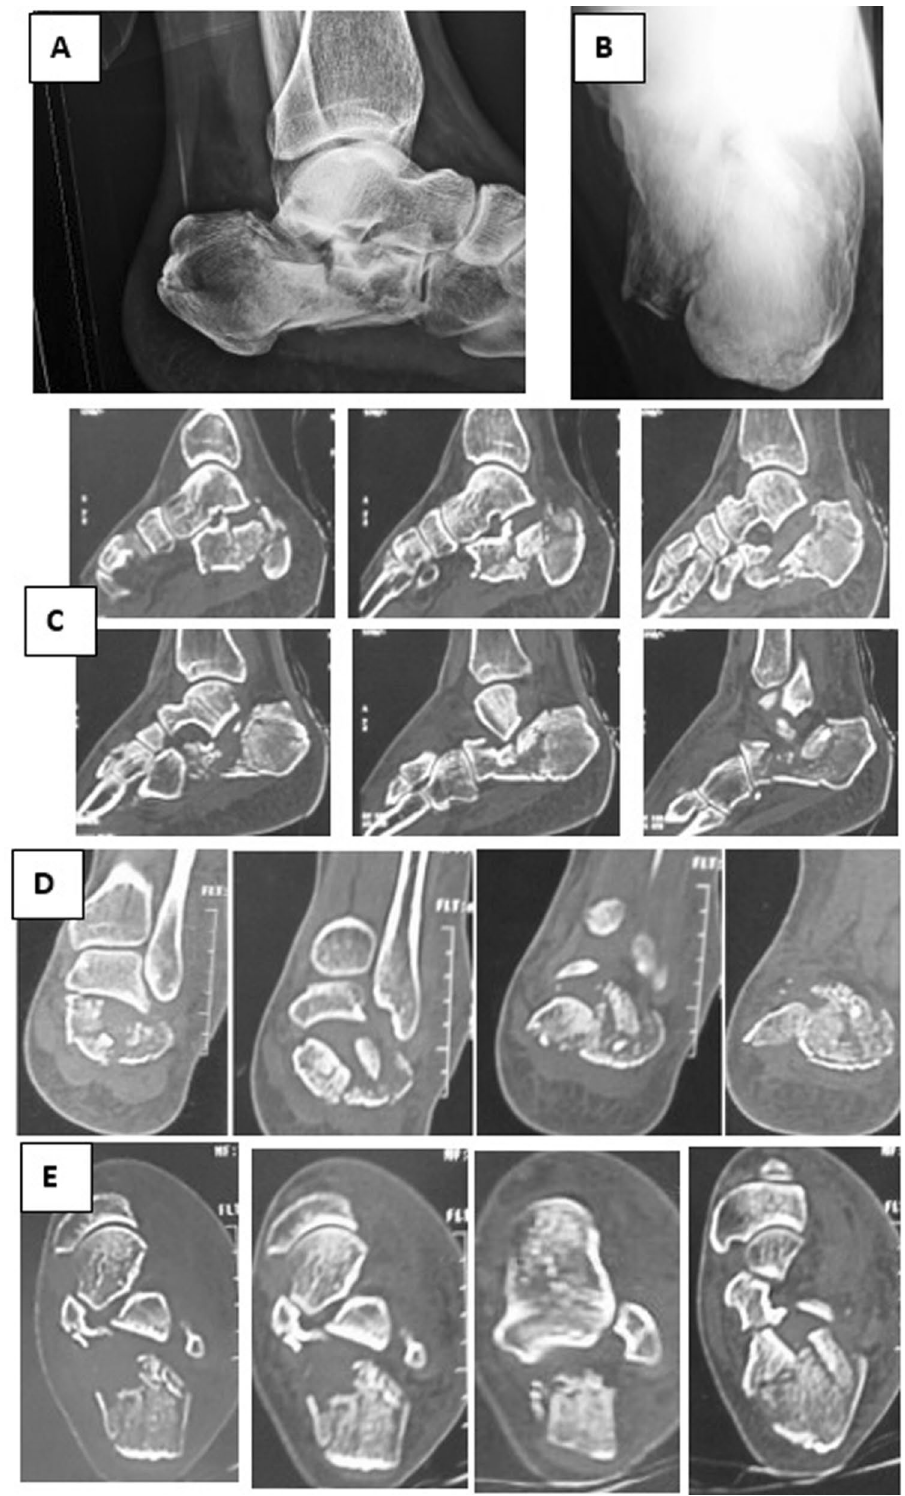
Fig. 1 Preoperative radiographs of a displaced intra‑articular calcaneal fracture: A lateral plain ankle X‑ray showing the depressed articular surface of the calcaneus; B axial view of the calcaneus; C , D , E sagittal, coronal and axial CT cuts,